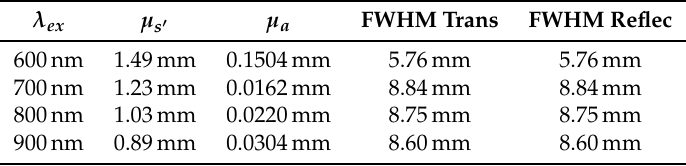
Table A1. Resolution for a range of excitation wavelengths for scanning system. λ em = 1000nm.